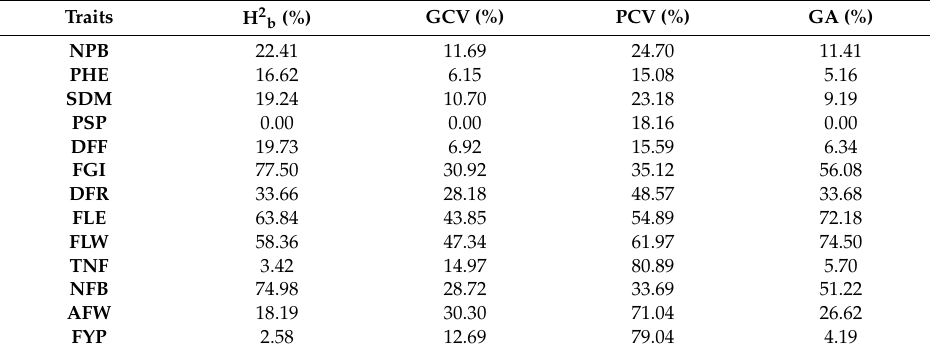
Table 6. Heritability and genetic variances for quantitative traits.